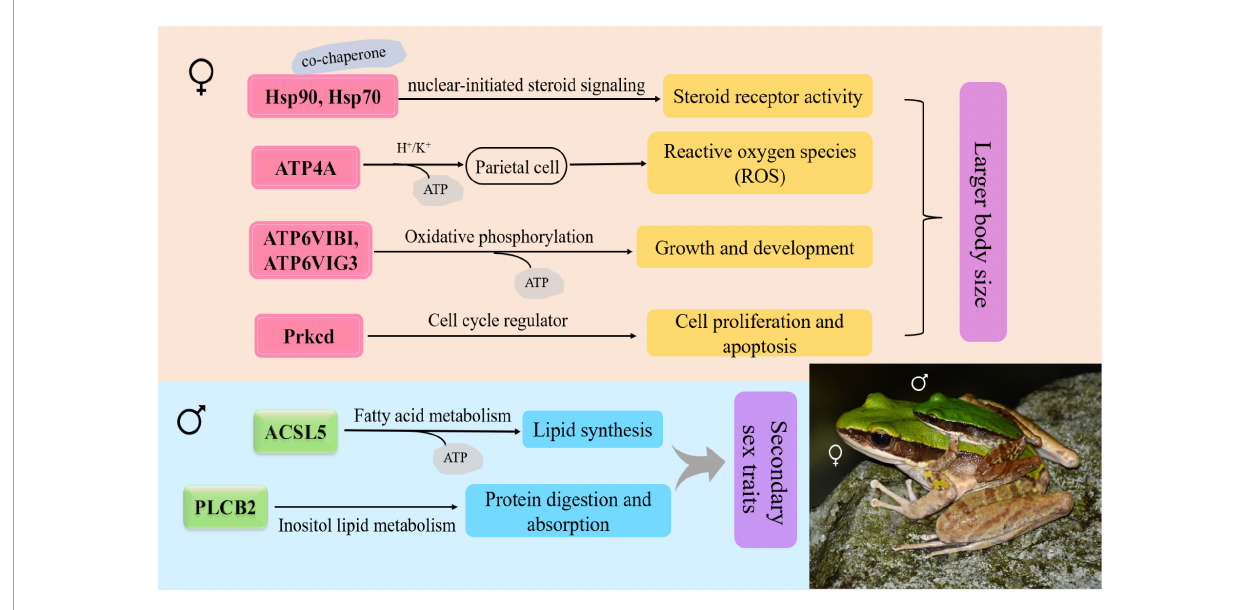
FIGURE5 Schematic diagram for the functions of the sexual size dimorphism (SSD)-related differentially expressed genes (DEGs) between sexes in O. graminea . Red showed the upregulated DEG of females, green showed the upregulated DEGs, and the arrow showed the upregulated genes.